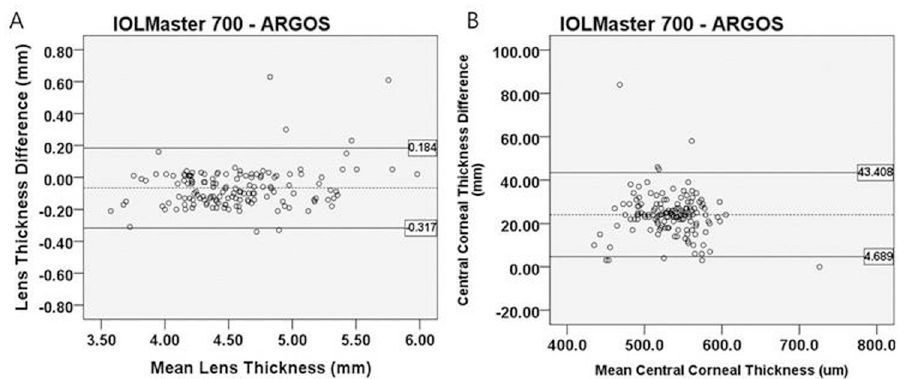
Fig 5. Bland-Altman plot for the LT and CCT measured by two SS-OCT devices. The mean difference is indicated by the dashed lines, and 95% LoA is indicated by the solid line. LT (A); CCT (B).